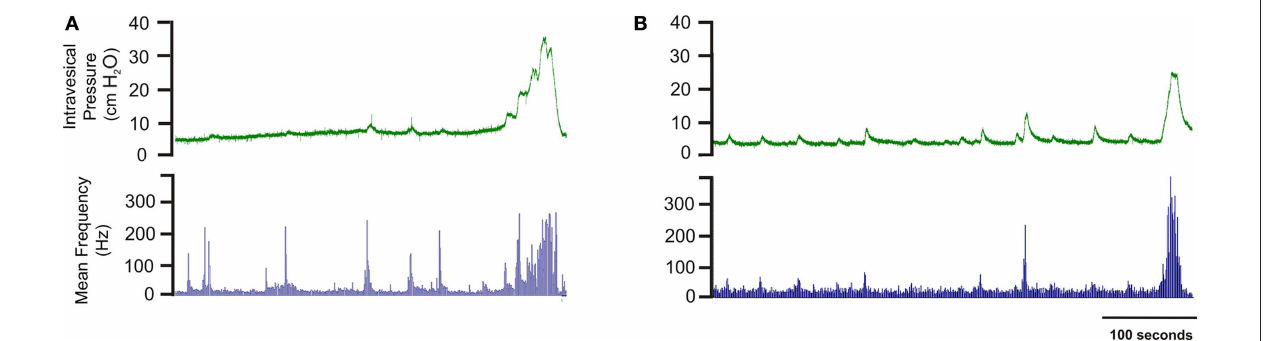
(B) Phasic components (small fluctuations in pressure) during the entire filling